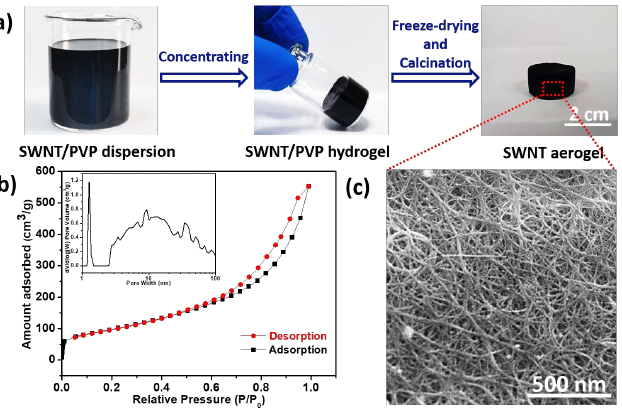
Figure 4. ( a ) Photographs of the SWNT/PVP dispersion, SWNT/PVP hydrogel, and SWNT aerogel. ( b ) N 2 adsorption–desorption isotherm of SWNT aerogels. Inset is the pore size distribution profile obtained from the adsorption branch. ( c ) SEM image of SWNT aerogels.